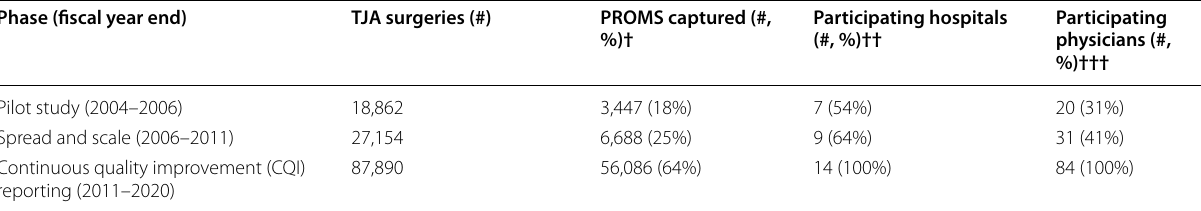
† Includes all surgical patients who completed both a pre-surgery and 3-month post-surgery PROMs survey †† Includes all hospitals who perform elective hip and knee arthroplasty in Alberta †† † Includes all physicians who performed at least 10 arthroplasty surgeries per